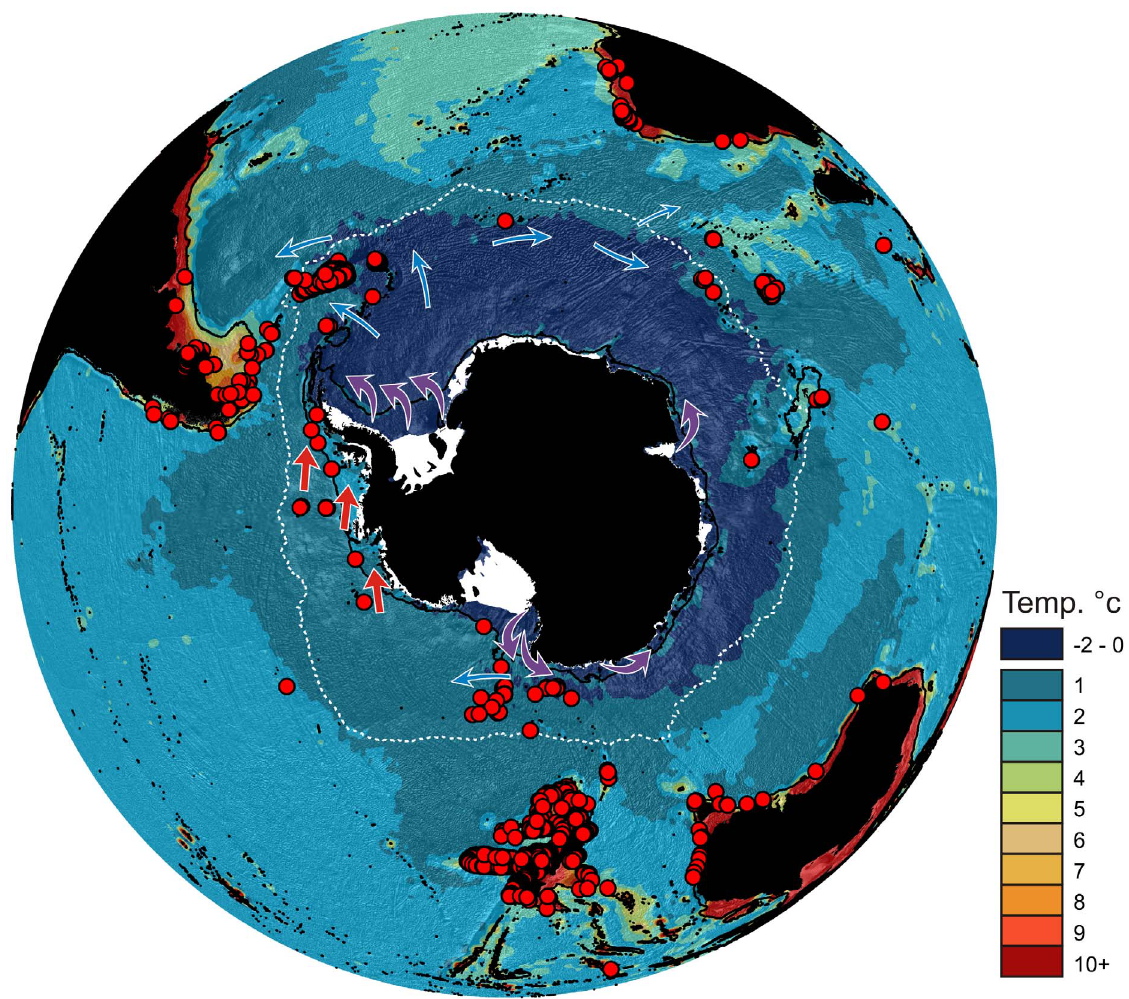
Figure 1. Geographic distribution of recorded Lithodidae from the Southern Ocean with seafloor temperature. Lithodid crab records=red circles, mean position of Polar Front (Moore et al., 1999)=white dotted line, Purple arrows=ABW production, Blue arrows=ABW direction (Orsi 2010 Nat Geo Sci), Red arrows=Circumpolar Deep Water on shelf. Temperature data from Clarke et al., 2009.